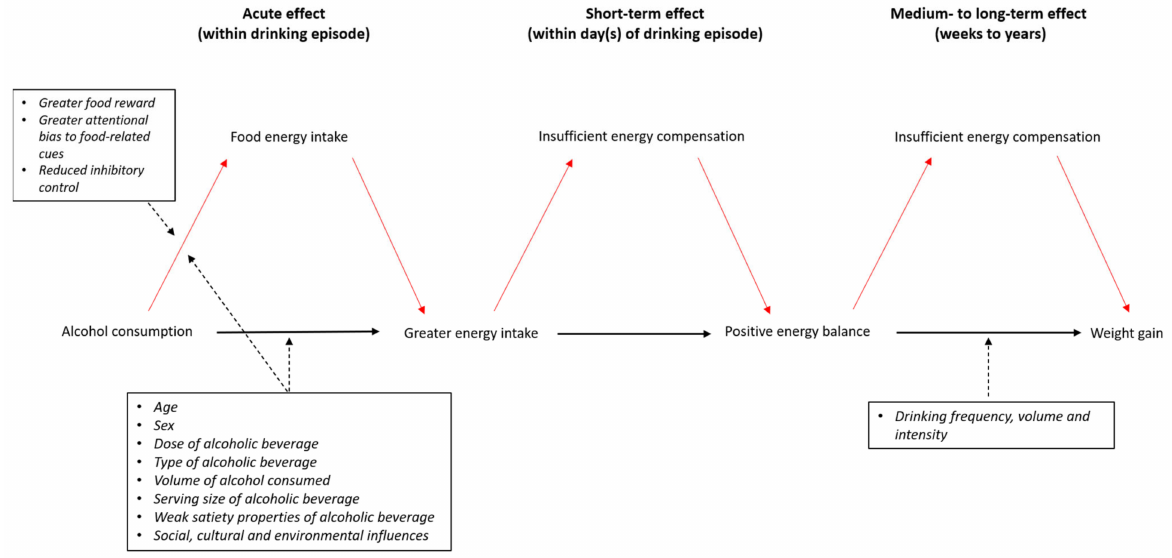
Figure 1. The hypothesised causal pathway from alcohol intake to weight gain. The red lines represent a proposed mediational relationship, and the dotted black lines represent proposed moderation. Body weight and energy compensation are influenced by a significant number of factors; these are beyond the scope of this review and have intentionally been omitted from this